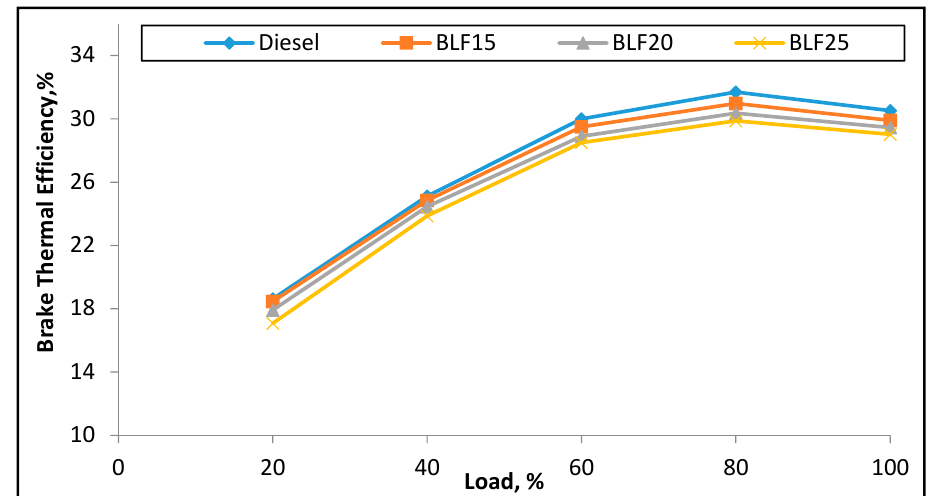
Figure 8. Variations of BTE vs. load percent.